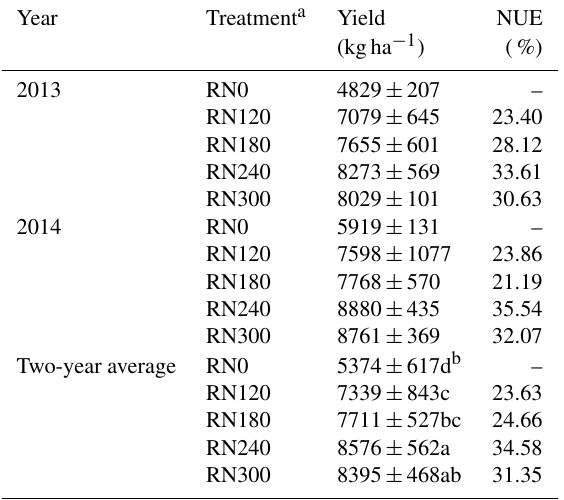
Table 3. Rice yield and nitrogen use efficiency (NUE) for the two rice-growing seasons from 2013 to 2014 in the Taihu Lake